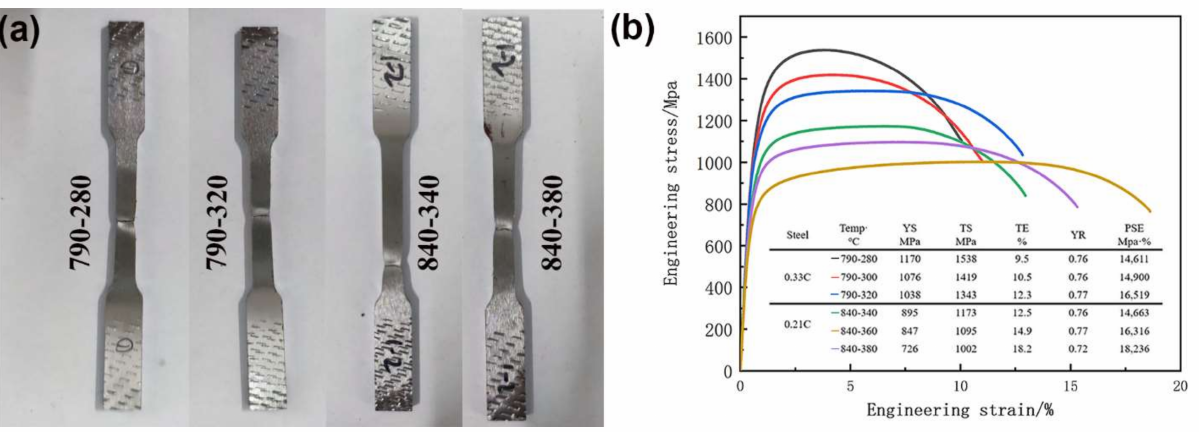
Figure 8. ( a ) Tensile samples after deformation and ( b ) stress–strain curves and tensile properties of both steels at different heat treatment